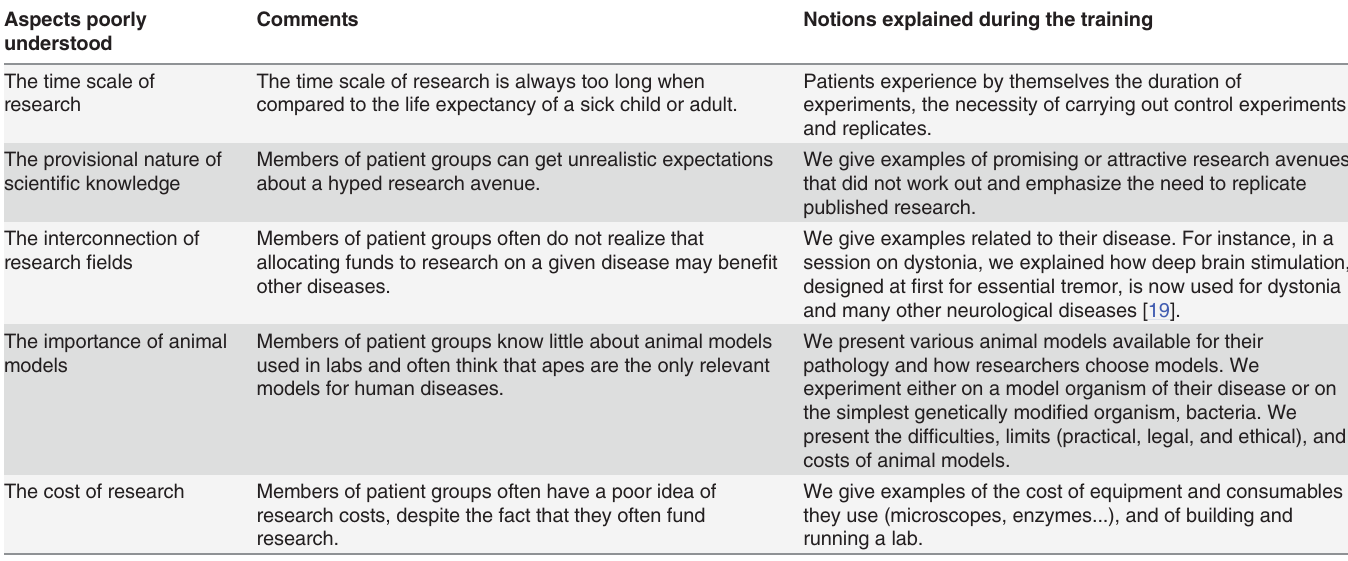
Table 1. Aspects of the scienti fi c method that patients often understand